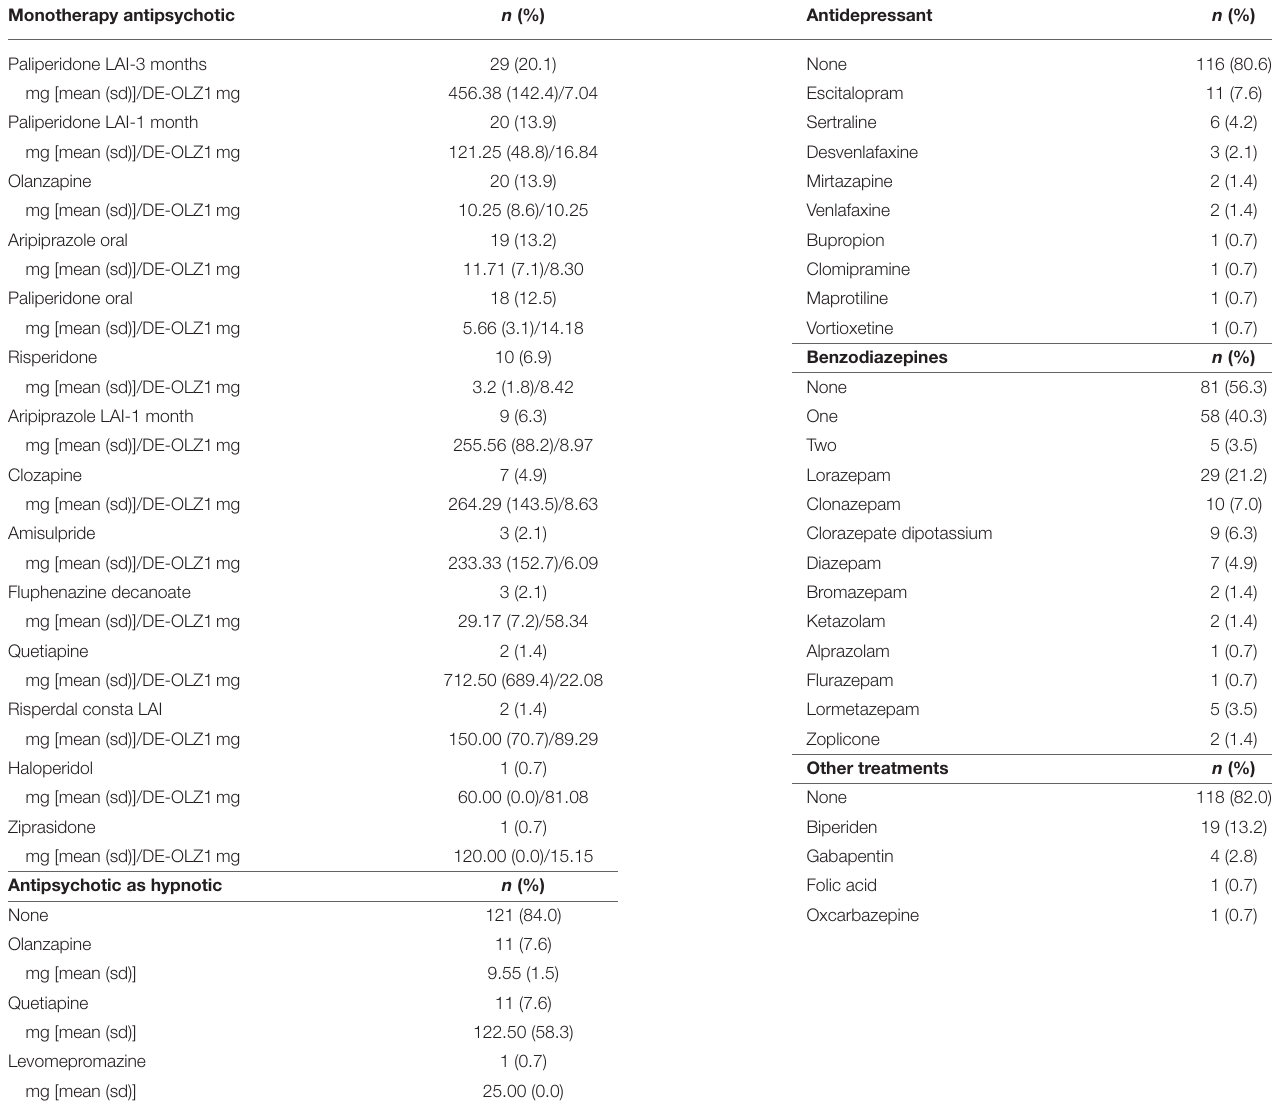
TABLE 2 | Prescribed pharmacological treatment in descending order of frequency. Monotherapy antipsychotic n (%) Antidepressant n